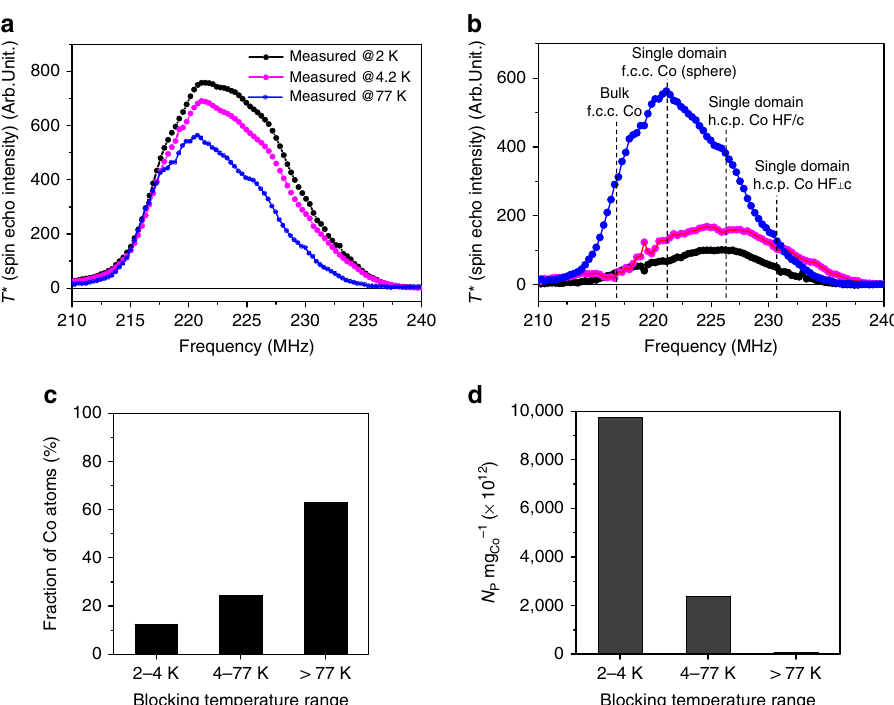
Figure 1 | 59 Co FNR spectra of cobalt nanoparticles versus temperature. ( a ) The 59 Co zero field FNR spectra recorded at 2 (black), 4.2 (magenta) and 77K (blue). ( b ) TDFNR spectra: in black spectrum measured at 2K minus spectrum measured at 4.2K; in magenta spectrum at 4.2K minus spectrum at 77K; in blue spectrum at 77K. Co can have an f.c.c. or an h.c.p. structure and be in two magnetic states: single domain or multi-domain. ( c ) The fractions of cobalt atoms engaged in the different blocking temperature ranges. ( d ) Numbers of Co particles per mg of cobalt ( N p mg Co (cid:2) 1 ) in different blocking temperature ranges. 2–4.2K range corresponds to 3–4nm particles, 4.2–77K range to 4–10nm; 4 77K corresponds to particles larger than